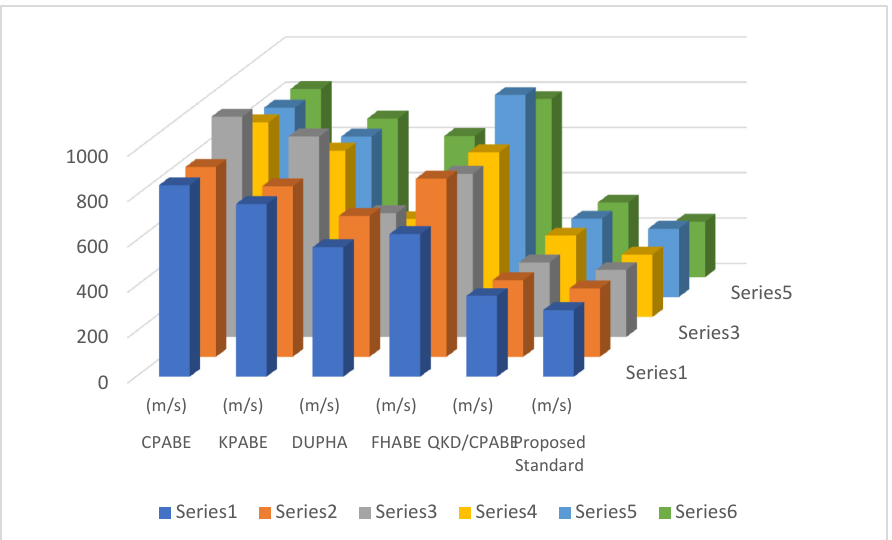
Figure 7. Relative investigational analysis of processing time band of planned standard over the conventional standards on dissimilar datasets.